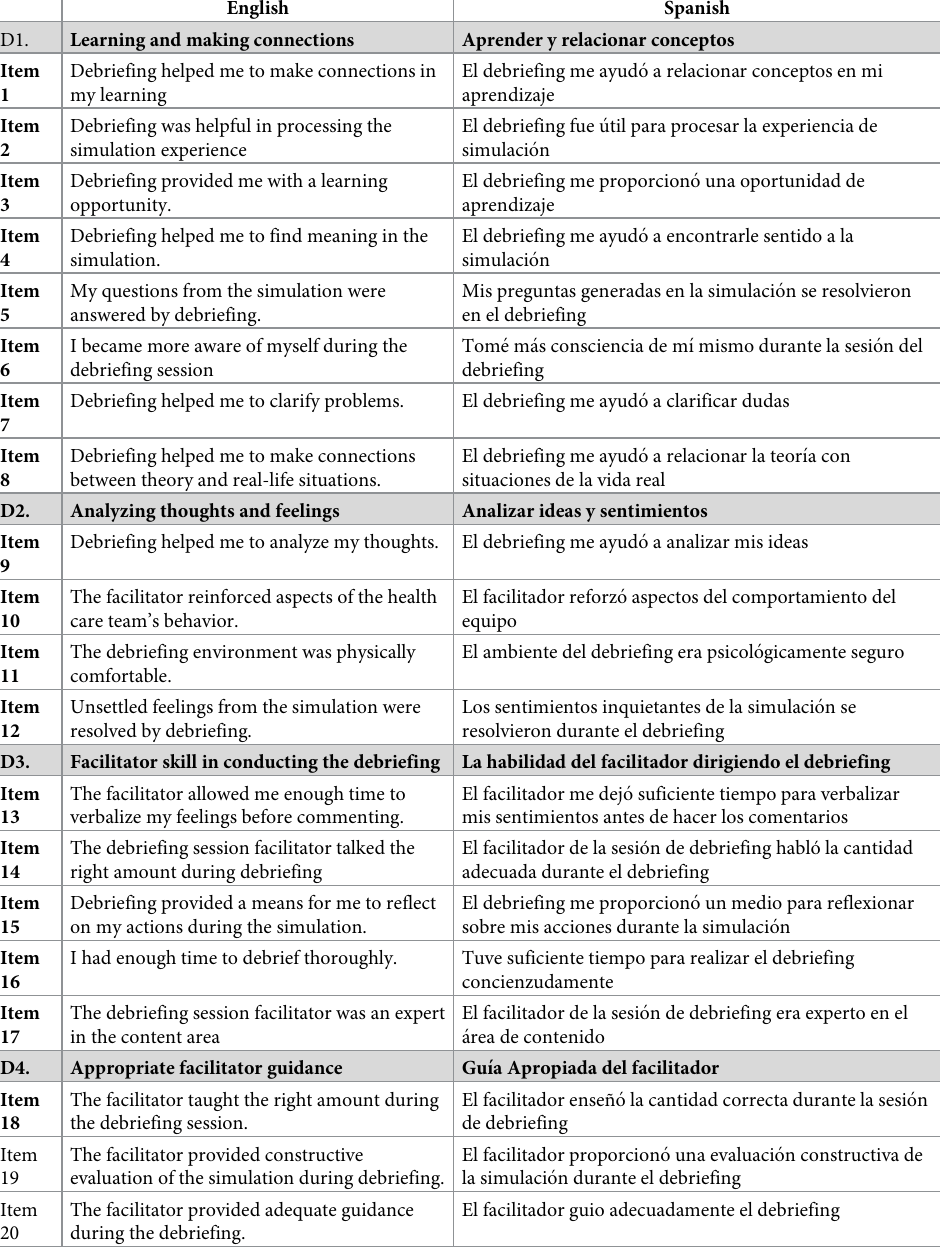
Table 1. Shows the semantic equivalence of items from English to Spanish that were psychometrically